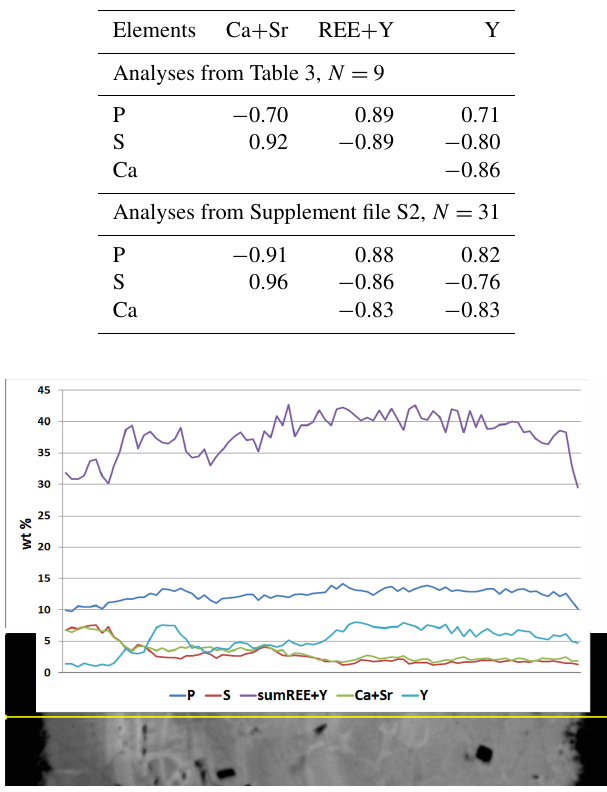
Figure 4. Microgeochemical profile through a spherical rhabdo- phane particle from Fig.